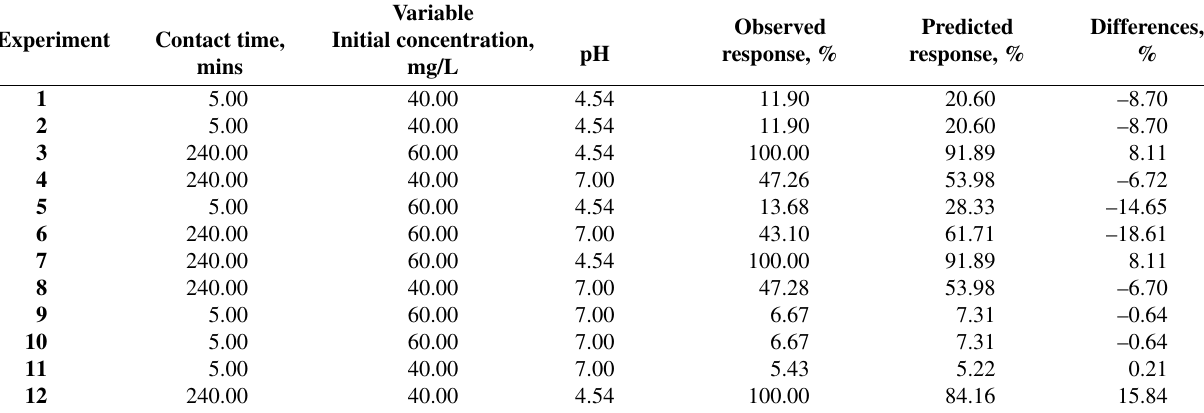
Table 4. Plackett-Burman design and results for the percentage removal of AY17 in binary dye solution